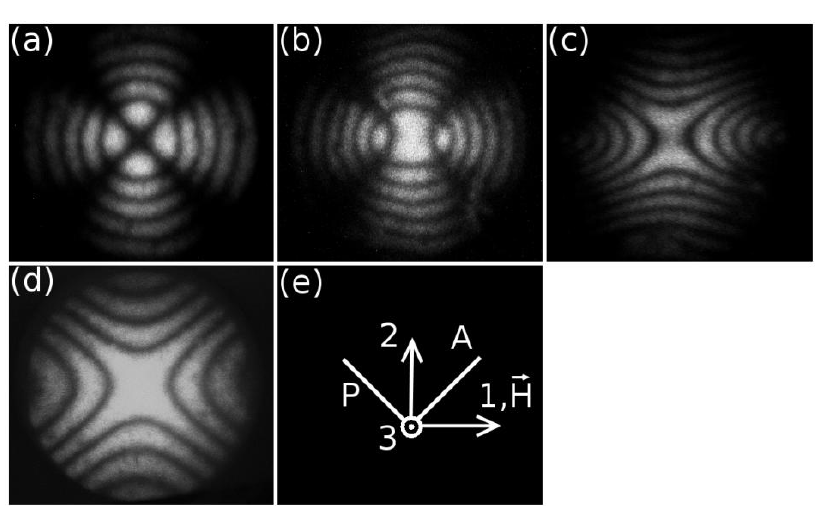
Figure 1. Typical conoscopic patterns of the mixture, potassium N -dodecanoyl- DL -serinate ( DL -KDDS)/Na SO /1-dodecanol (DDeOH)/water. ( a ) nematic discotic phase ( N 2 4 45.0 °C; ( b ) nematic biaxial phase ( N ) near the N to N transition at 33.7 °C; ( c ) N B D B 31.0 °C; and ( d ) calamitic nematic phase ( N ) at 23.0 °C; ( e ) geometry of the experiment: C P , A and are the directions of the polarizer, analyzer and the applied magnetic field,